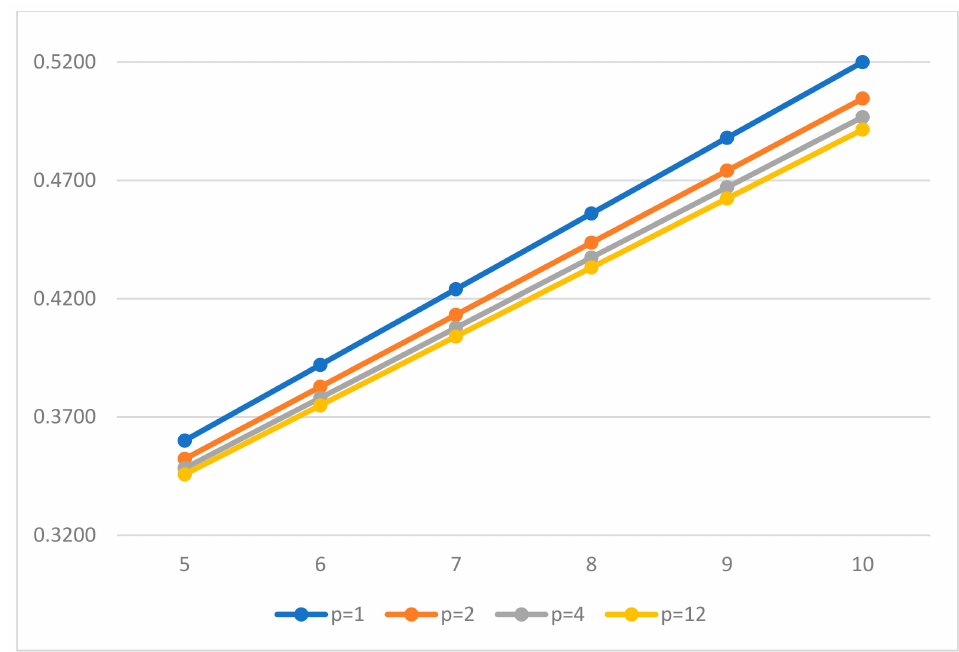
Figure 17. Dependence of the equity cost, k e , on leverage level L at different p (1; 2; 4; 12) and fixed k d = 0.16 (lager